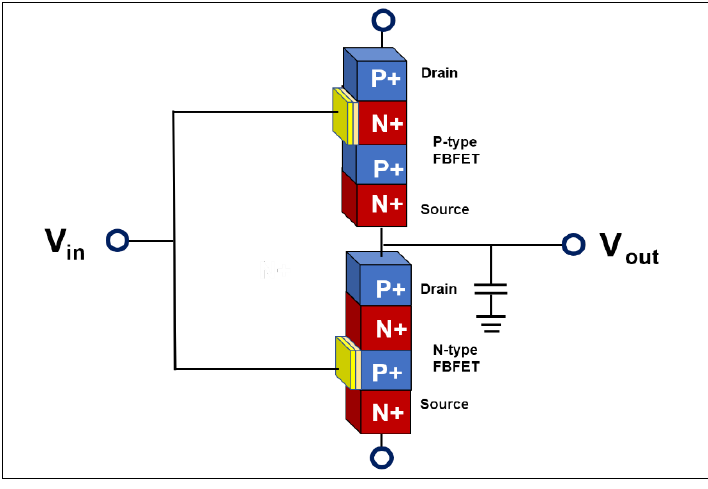
Figure 8. Illustration of an FBFET-based inverter circuit.